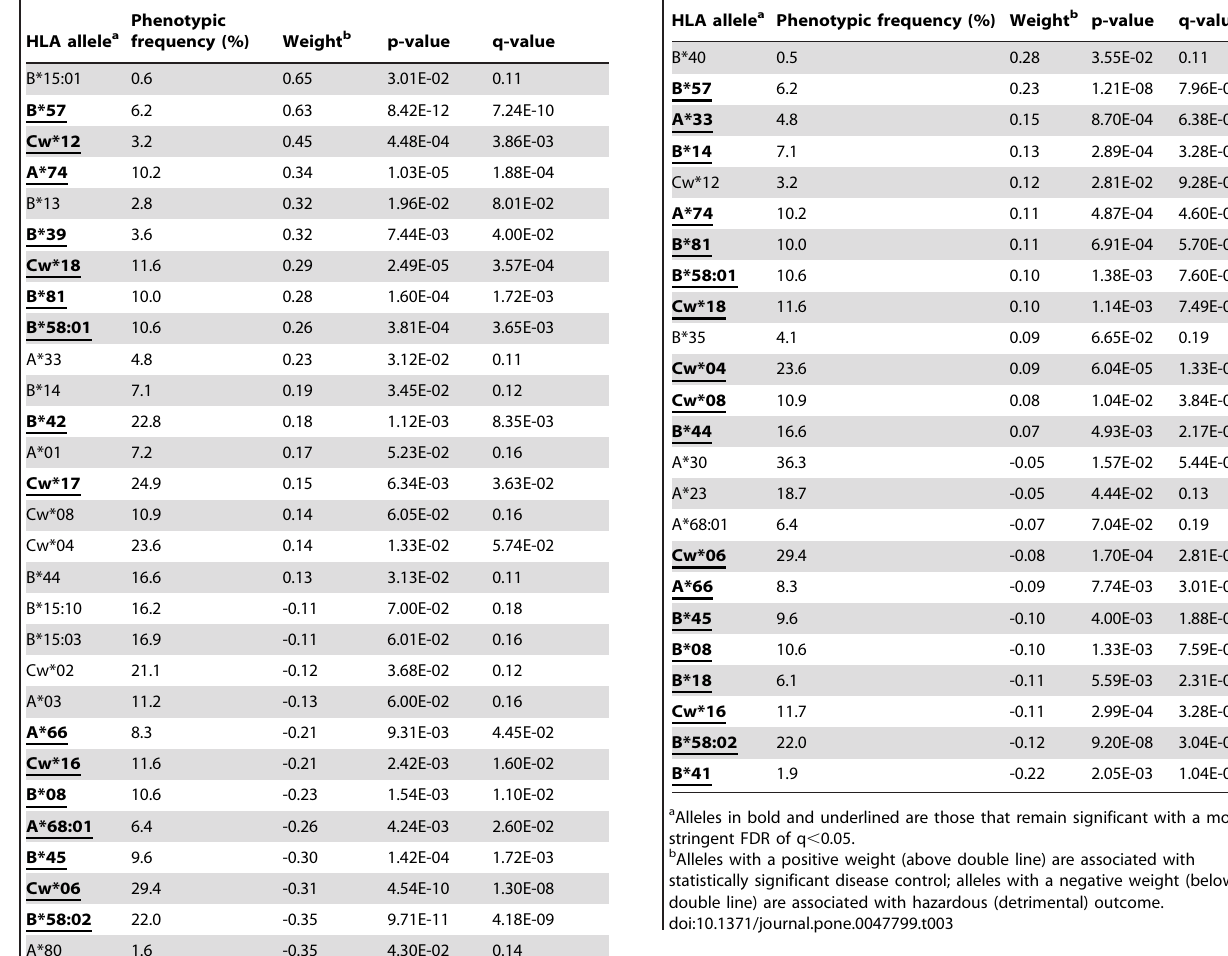
Table 2. Univariate analysis of the impact of HLA Class I alleles on HIV-1 viral load in 2031 HIV-1 C-clade infected Southern African subjects (q , 0.2).